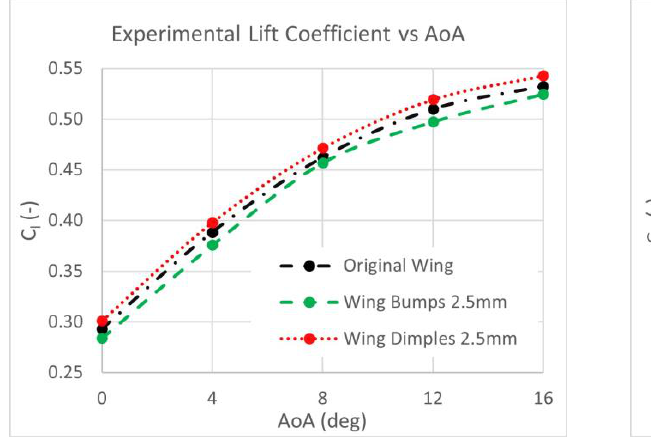
Figure 19. Experimental coefficients ( a ) of lift and ( b ) of drag for the three wing configurations.